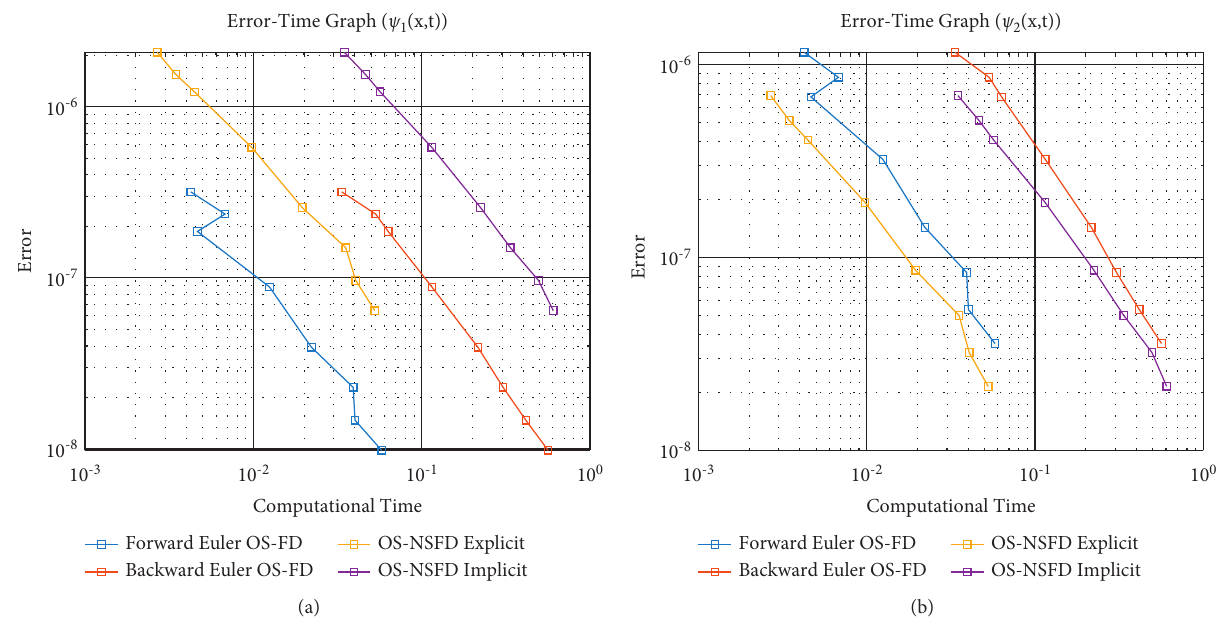
Figure 11: Log-log graphs. The error versus the computational time when solving the system subjected to the initial data. Three schemes are employed: forward Euler OS-FD technique, backward Euler OS-FD technique, OS-NSFD explicit technique, and OS-NSFD implicit technique. The graphs correspond to the solutions when the functions ψ and ψ of the Brusselator model are estimated. The parameters 1 2 � 0 . 05 , ϑ � 0 . 02, M � 100, and ε � ε � 10 − 4 . The exact solution was approximated using N � 20000. (a) employed are L � 1, T � 1, ϑ 1 2 ψ 1 ψ 1 Error time graph for ψ . (b) Error time graph for ψ . 1 2